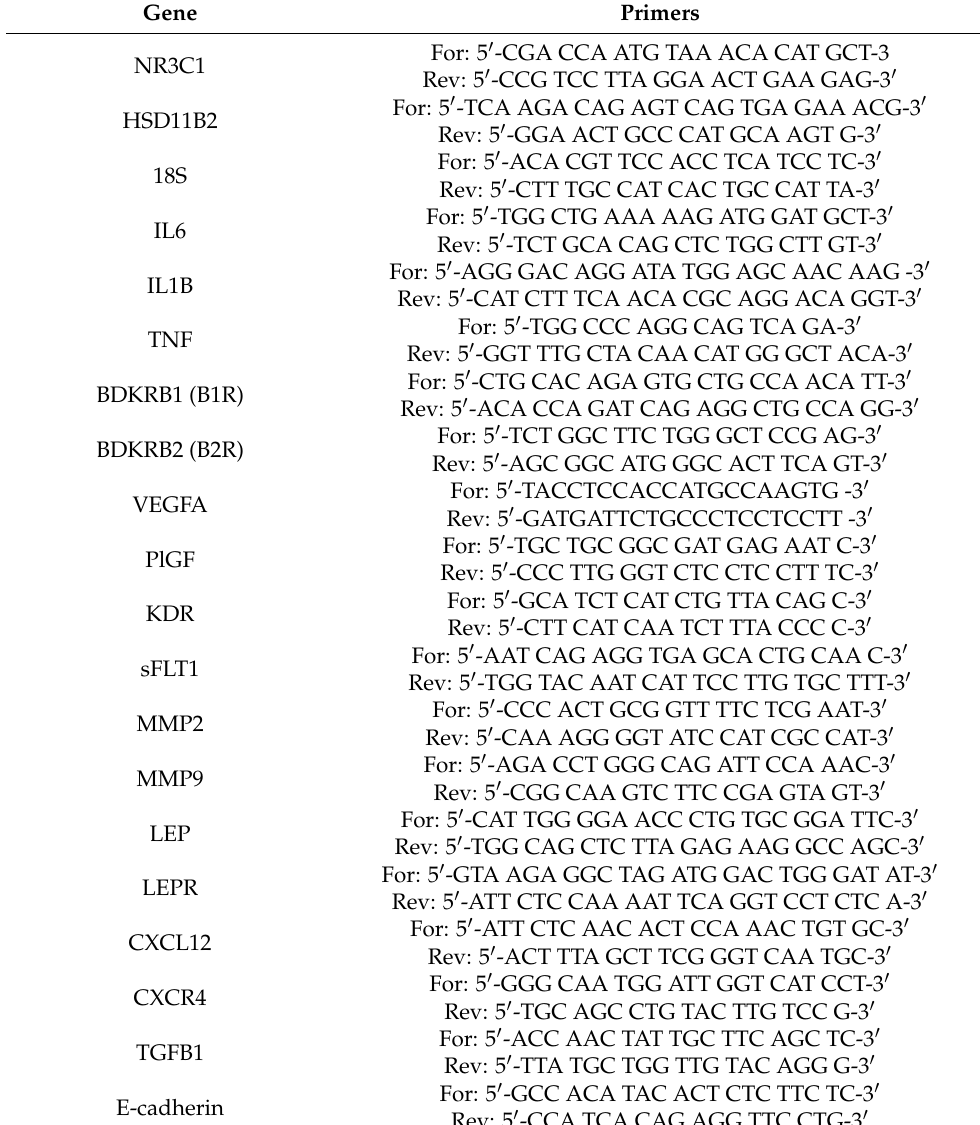
Table A1. Base pair sequences of primers used in real-time PCR